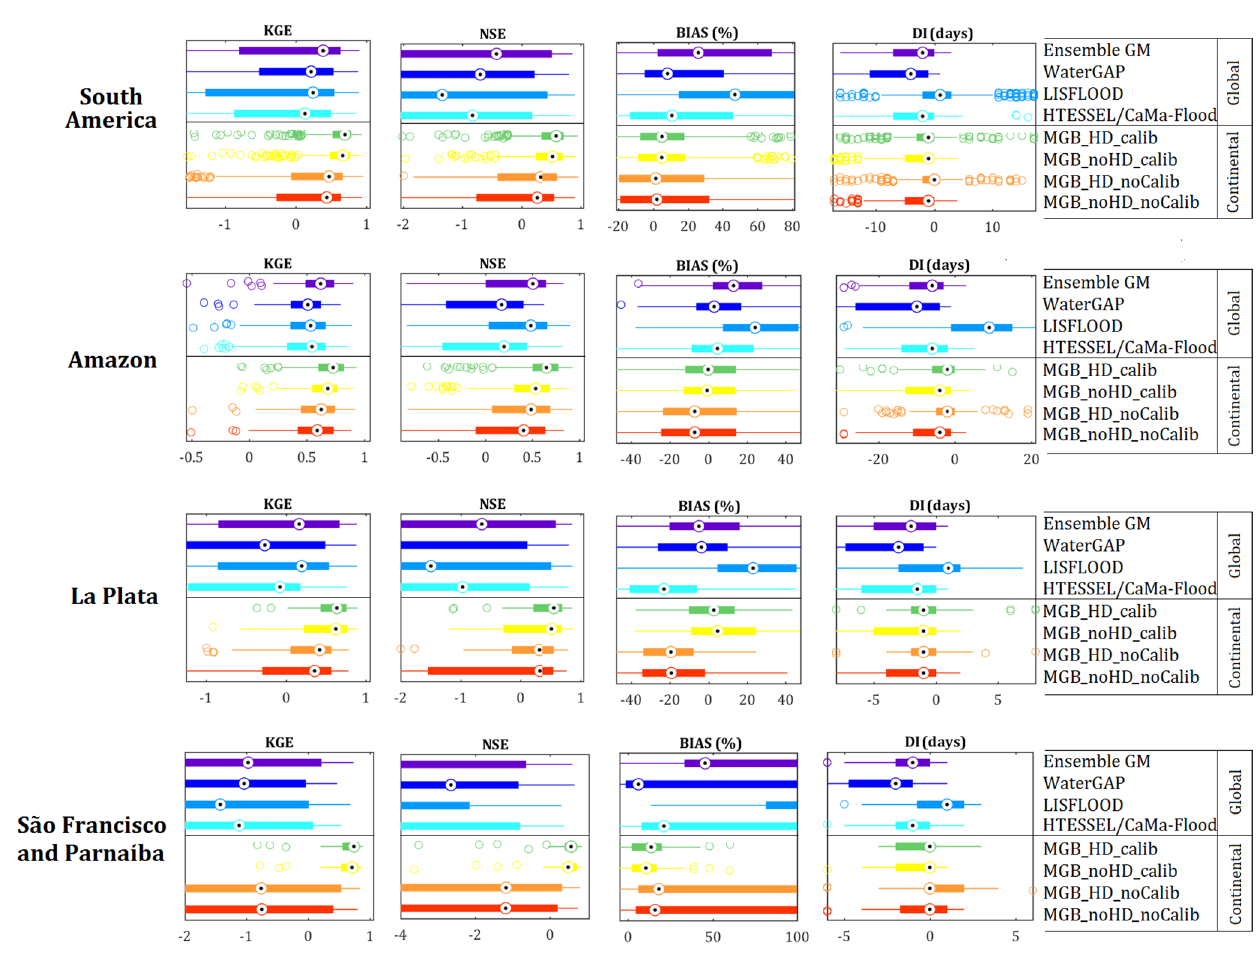
Figure 11. Box plots of global (above center line) and continental (below center line) model performances for different South American regions. MGB model configurations: hydrodynamic routing with calibrated rainfall-runoff parameters (MGB_HD_calib), hydrodynamic routing with uncalibrated rainfall-runoff parameters (MGB_ HD_noCalib), non-hydrodynamic routing with calibrated rainfall-runoff pa- rameters (MGB_noHD_calib) and non-hydrodynamic routing with uncalibrated rainfall-runoff parameters (MGB_noHD_noCalib). Gauge stations with naturalized flows were removed from the analysis to provide a fair